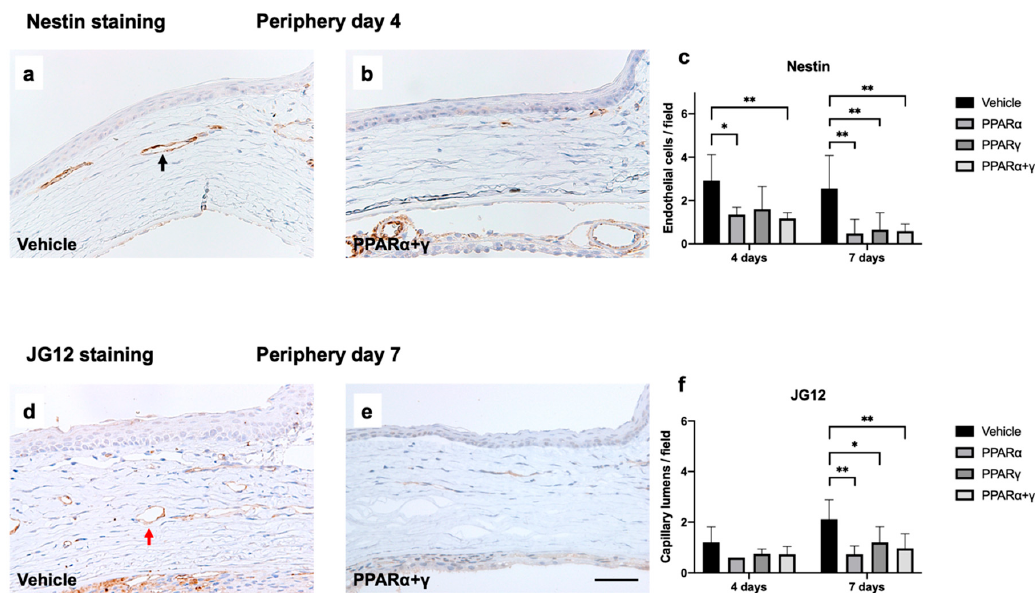
Figure 8. Immunohistochemical analysis of nestin ( a – c ) and JG12 ( d – f ) in the vehicle ( a ), ( d ) and PPAR α + γ ( b ), ( e ) groups. Bar, 50 µ m. Nestin-positive endothelial cells were observed during the early phase in the corneal limbus ( a ), ( b ). The black arrow indicates nestin-positive endothelial cells of a new blood vessel ( a ). Bar charts of the number of nestin-positive cells indicate that all PPAR agonist ophthalmic solutions reduced nestin-positive endothelial cells in the later phase (day 7). In the early phase (day 4), newly formed blood vessels were significantly lower in the PPAR α and PPAR α + γ groups than in the vehicle group ( c ). Data are presented as the mean ± standard error ( n = 8 samples/group). ** p < 0.01, * p < 0.05. JG-12-positive capillary lumens were observed on day 7 ( d ), ( e ). Red arrow indicates a JG12-positive cell ( d ). The number of capillaries increased by day 7 after corneal alkali injury in the vehicle group. Each PPAR treatment significantly suppressed the increase in capillary lumens by day 7 compared to the vehicle group ( f ). Data are presented as the mean ± standard error ( n = 8 samples/group). ** p < 0.01, * p < 0.05.